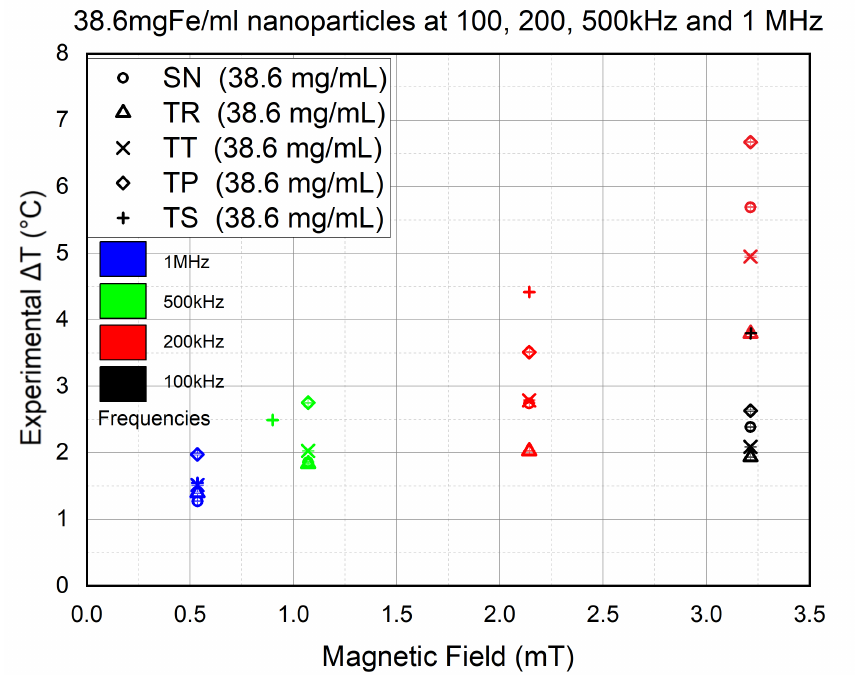
Figure 11. Concentration effect experiments result of 38.6 mgFe/mL MNPs at frequencies going from 100 kHz to red 1 Hz for 900 s at B going from 0.5 to 3.2 mT. The Error bars are barely seen due to their small value (<10 − 3